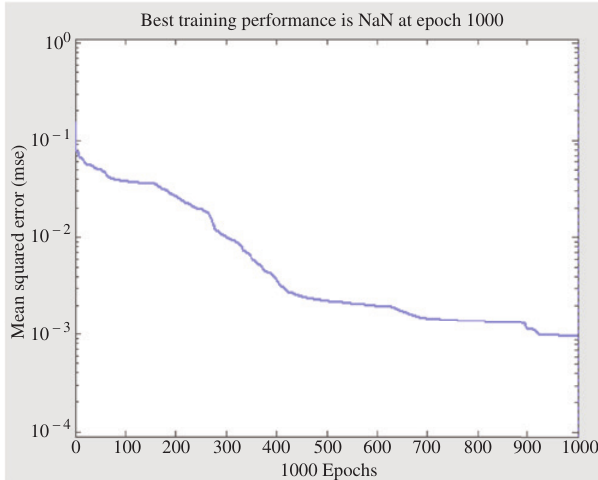
Figure 11: Performance Plot for net1.